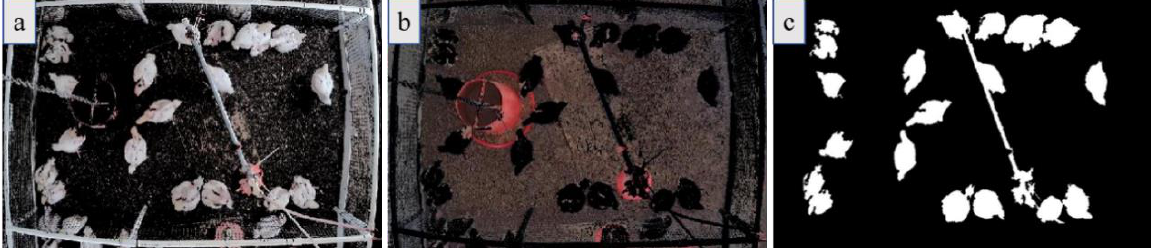
Figure 2. Examples of target detection results: ( a ) generation of binary image; ( b ) binary classification; and ( c ) the binary image obtained based on ( a ).